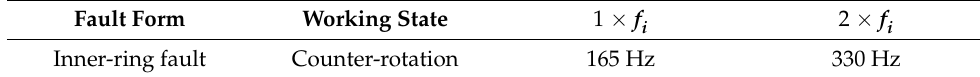
Table 4. The FCF of the IR